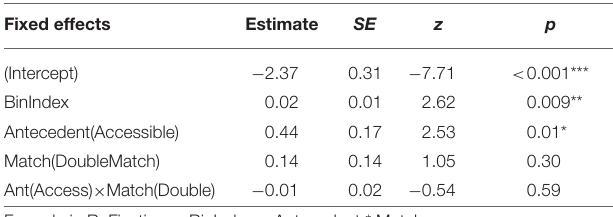
TABLE 2 | Fixed effects from best fitting mixed-effects logistic regression model fit to data for reflexives, Experiment 2. Fixed effects